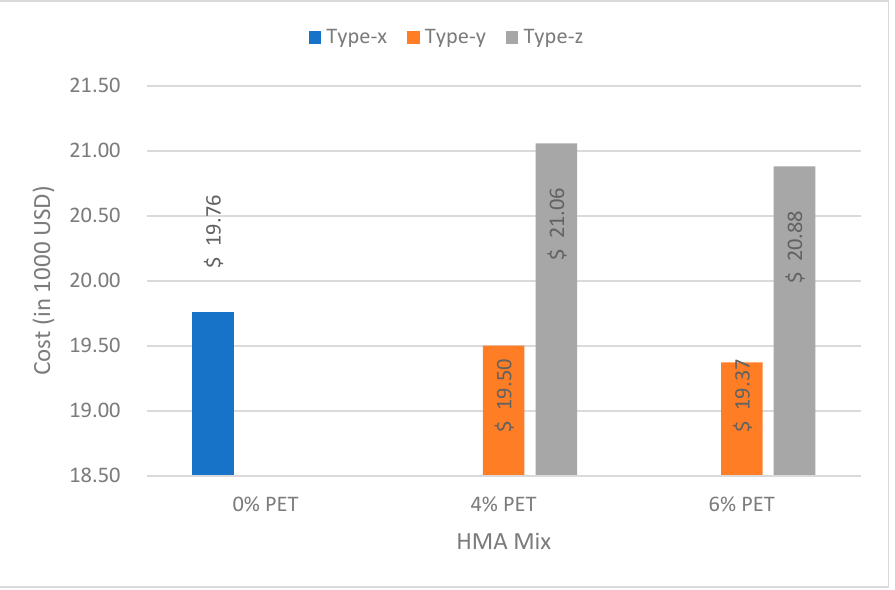
Figure 14. Cost comparison.